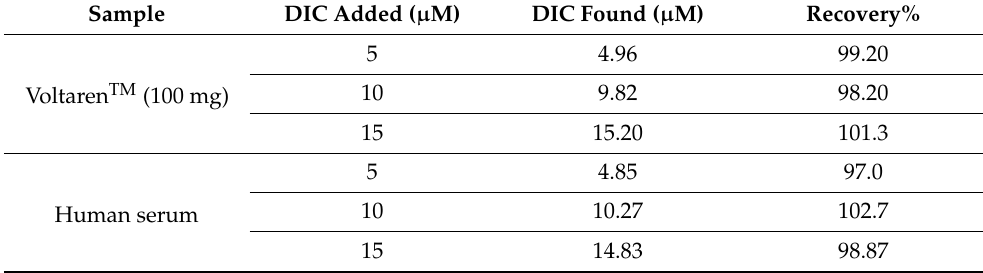
Table 2. The DPV analysis of DIC in the tablet and human serum as real samples at M-Chs